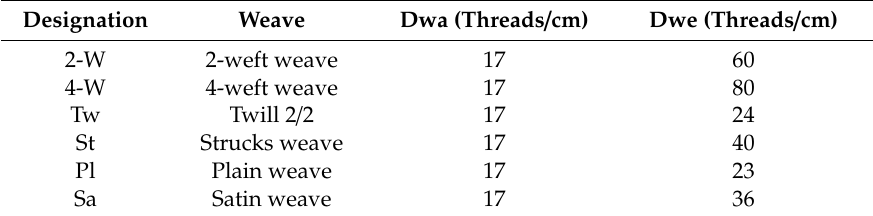
Table 1. Weave and density of fabrics